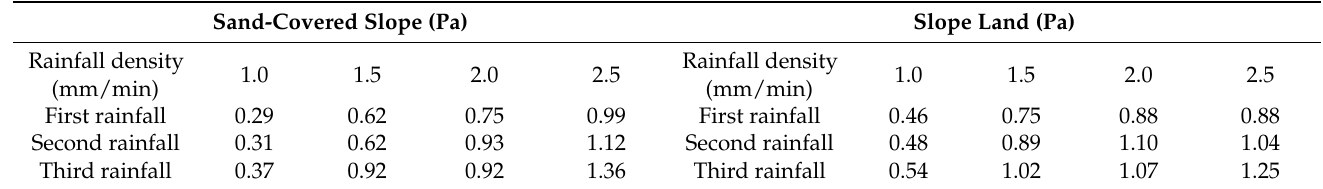
Table 5. Average runoff shear stress of downslope with different rainfall densities and rainfall applications. Sand-Covered Slope (Pa)